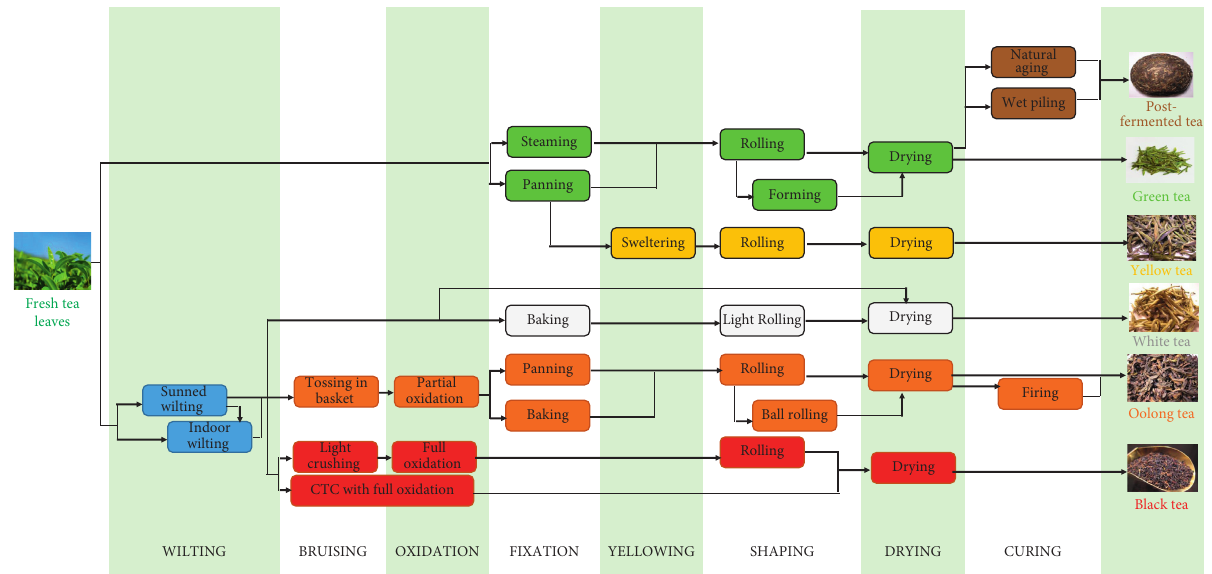
Figure 1: The production process of various